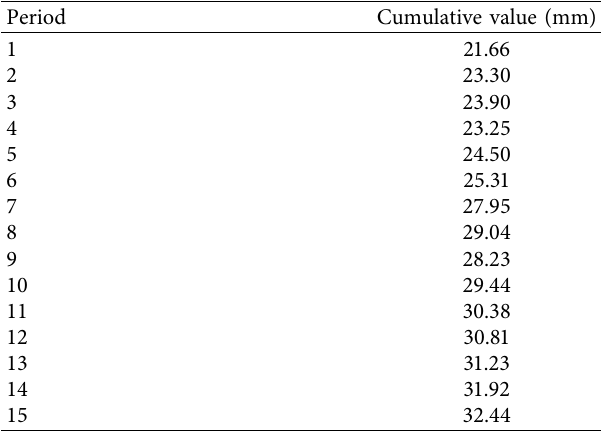
Table 2: Cumulative value of B16 monitoring points.